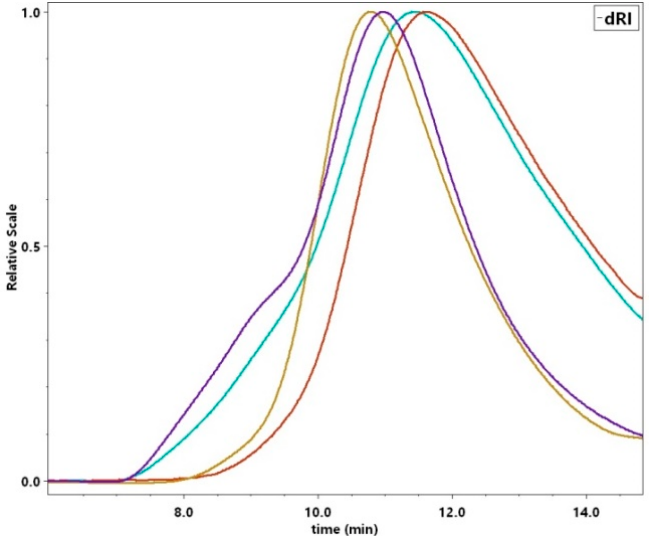
Figure A2. Comparison of size exclusion chromatography (SEC) chromatograms obtained from the refractive index (RI) detector. Polymer precursor 1 (yellow curve), polymer conjugate REF (purple curve), and CPP–polymer conjugates TAT12 (orange curve) and PEN12 (blue curve).